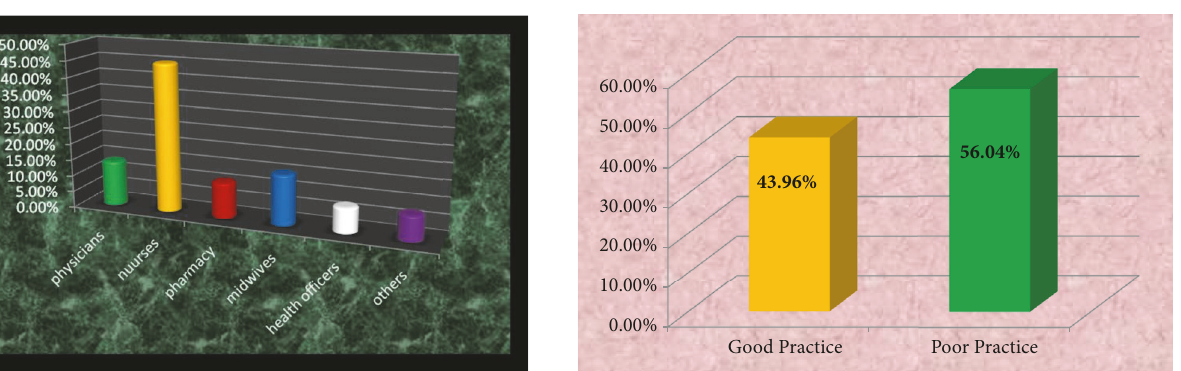
Figure 4: Distribution of hand washing of practice level in Dubti Referral Hospital among health professionals, April